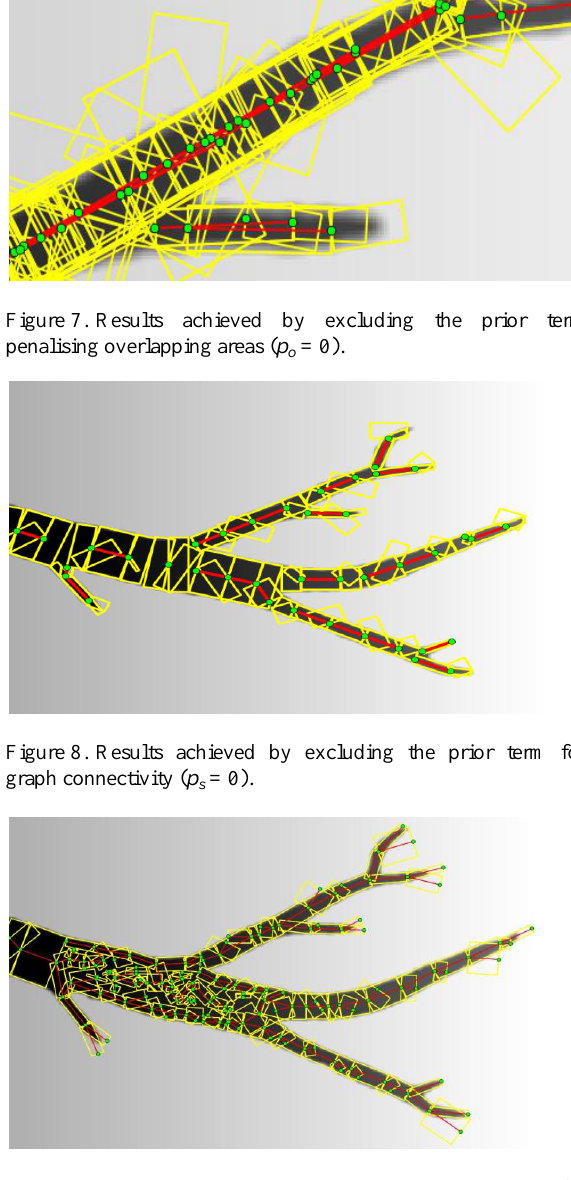
Figure 9. Results achieved by excluding the prior term for typical angles ( p a =